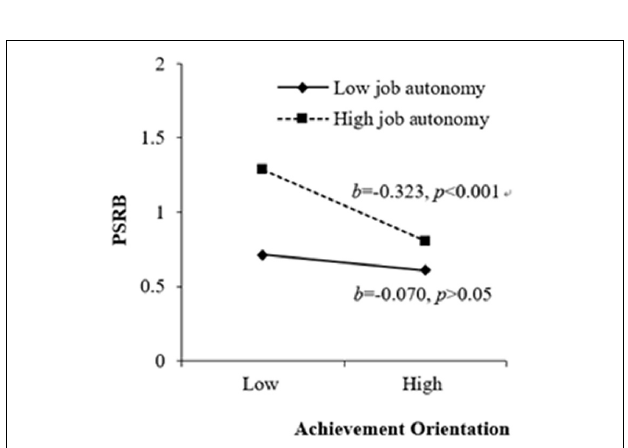
FIGURE 3 | Moderating effect of job autonomy between achievement orientation and PSRB.